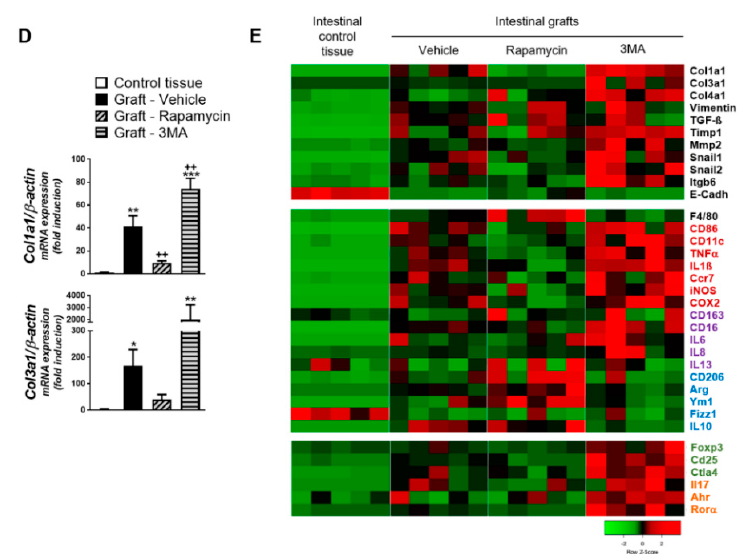
Figure 1. Murine fibrosis is reduced by autophagy stimulation and increased by autophagy inhibition. Murine intestinal fibrosis was induced by the heterotopic transplant of colonic tissue. Autophagy and fibrotic markers were analyzed in intestinal control tissues and the intestinal grafts resected seven days after transplantation from mice receiving a daily intraperitoneal injection of the autophagy stimulator rapamycin (1.25 mg/kg mice), the autophagy inhibitor 3-Methyladenine (3-MA, 10 mg/kg mice) or their vehicle (DMSO 1%, n = 5 each). ( A ) Representative Western blots showing the protein levels of the autophagy substrate P62, the autophagy protein Beclin-1, the two forms of LC3 (LC3-I, cytoplasmic; LC3-II, autophagosome-associated) and of Glyceraldehyde-3-Phosphate Dehydrogenase (GAPDH). The accumulation of P62 and the reduction in Beclin-1 and LC3-II in the explants from vehicle-treated mice indicate an inhibited autophagy that was partially prevented by rapamycin- and promoted by 3-MA- treatments ( B ). ( C ) Representative pictures of Sirius Red staining in paraffin-embedded tissues where the red color indicates collagen deposition (20× and 40× magnification in upper and lower panels respectively), and ( D ) mRNA expression of fibrous collagens ( Col1a1, Col3a1 ) analyzed by qPCR (results normalized with β -actin and represented as fold induction vs. intestinal control tissues). ( E ) Heatmap showing the relative mRNA expression of genes involved in (i) fibrosis and epithelial to mesenchymal transition; (ii) inflammation: the general macrophage marker (F4 / 80), pro-inflammatory (red), anti-inflammatory (blue) and pro-fibrotic (purple) molecules; and (iii) T lymphocyte markers (regulatory T cells—green, Th17—orange). Bars in graphs represent mean ± S.E.M. Significant di ff erences vs. control intestinal tissues are shown by * p < 0.05, ** p < 0.01 and *** p < 0.001; significant di ff erences vs. grafts obtained from vehicle-treated mice are shown by ++ p < 0.01; as analyzed by ANOVA with a Newman–Keuls post hoc correction for